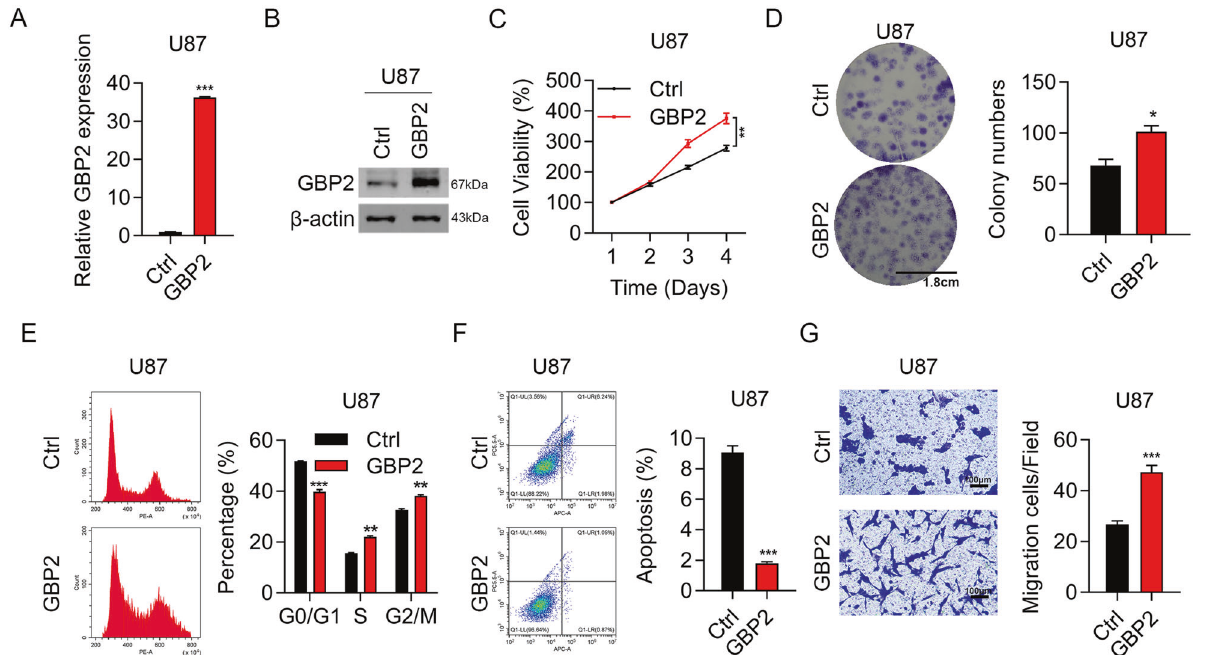
Fig. 3 Overexpression of GBP2 enhances proliferation and migration in glioma cells. A RT-qPCR results con fi rming overexpression of GBP2 at the mRNA level. B Western blotting results con fi rming overexpression of GBP2 at the protein level. C CCK8 analysis of cell proliferation in GFP- and GFP-GBP2-overexpressing U87 cells. D Colony formation analysis in GFP- and GFP-GBP2-overexpressing U87 cells. E Cell cycle analysis of U87 cells overexpressing GFP or GFP-GBP2 using PI staining. F Apoptosis analysis of GFP- and GFP-GBP2-overexpressing U87